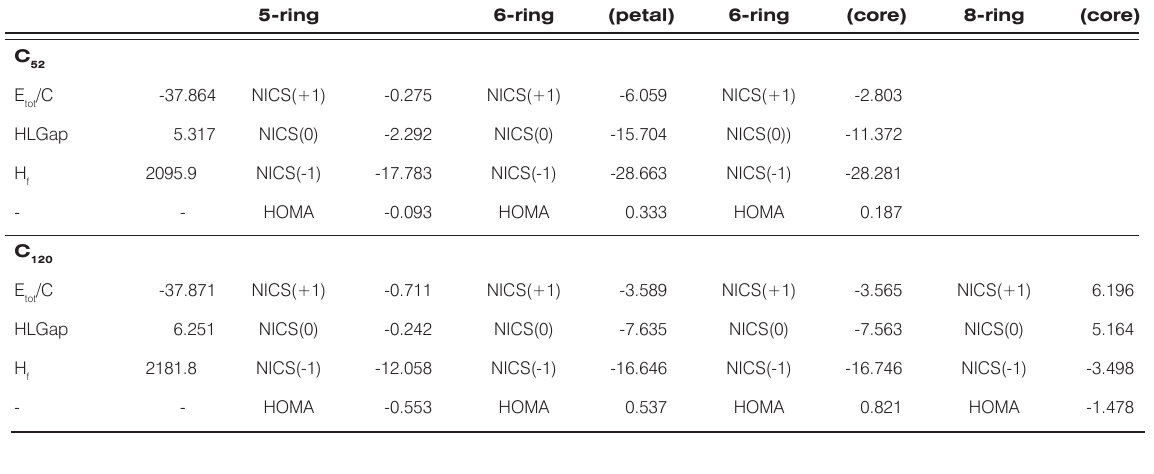
Table 8. Total energy per C atom, E /C (au), HOMO-LUMO gap, HLGap (eV), Heat of formation, H tot (HF/6-31G(d,p)) for cages